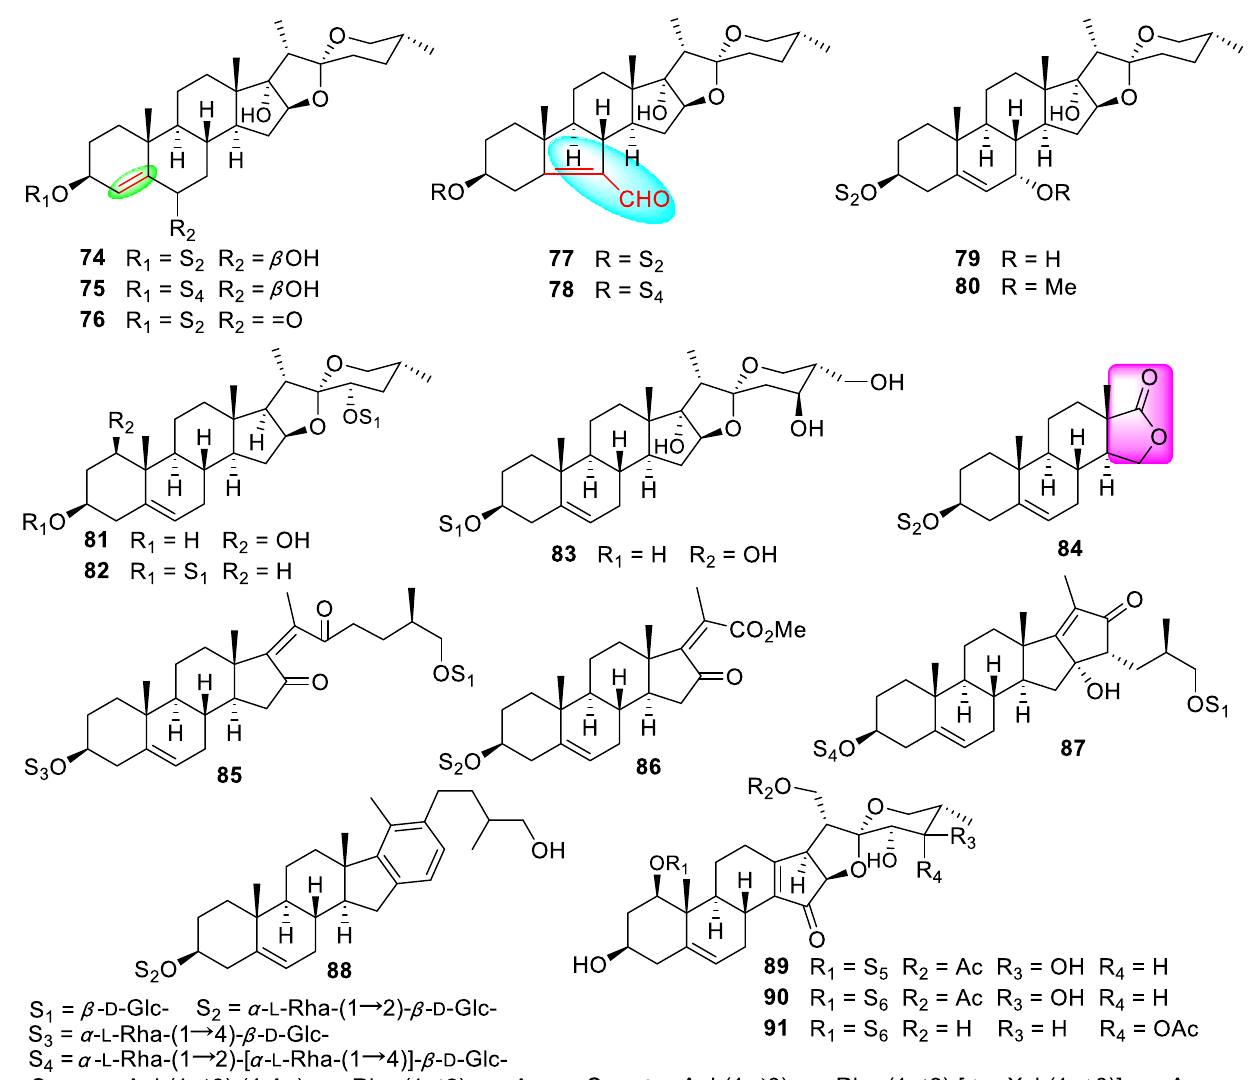
Fig. 3 New steroidal saponins from Trillium